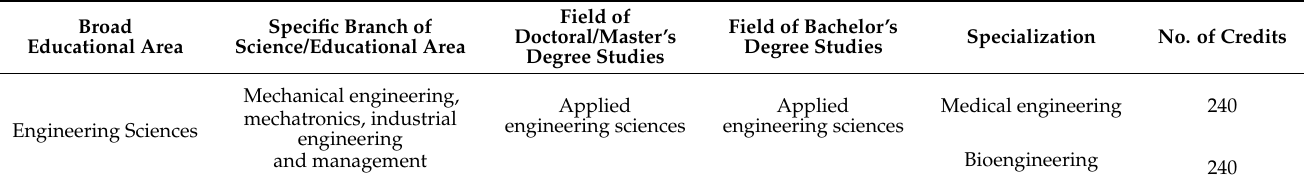
Table 2. Connection between broad educational area and BME specializations in Romania,